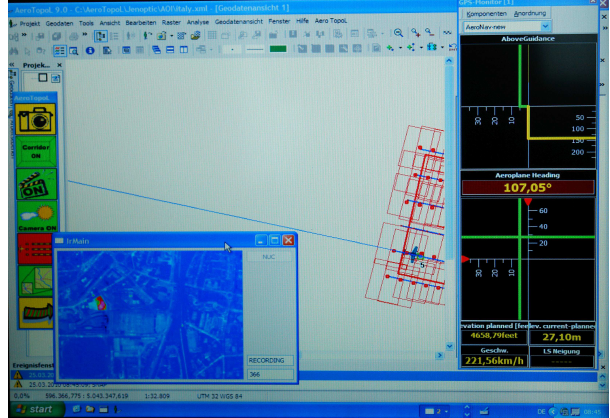
Figure 11: FMS AeroTopoL and the capture software IR Main with a